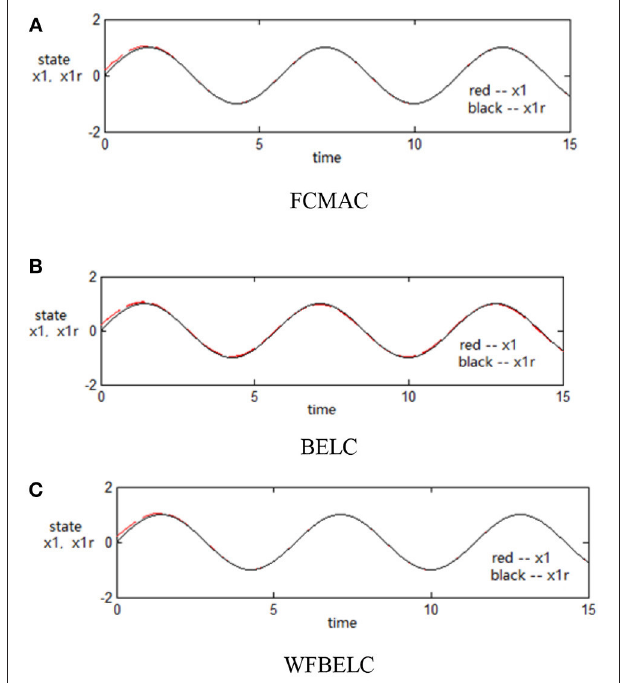
FIGURE 9 | Periodic orbit phase plane plots ( q = 8) (A) FCAMC (B) BELC (C) WFBELC.